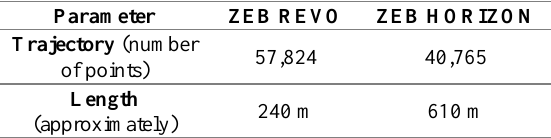
Table 3. Approximate length and number of trajectory points